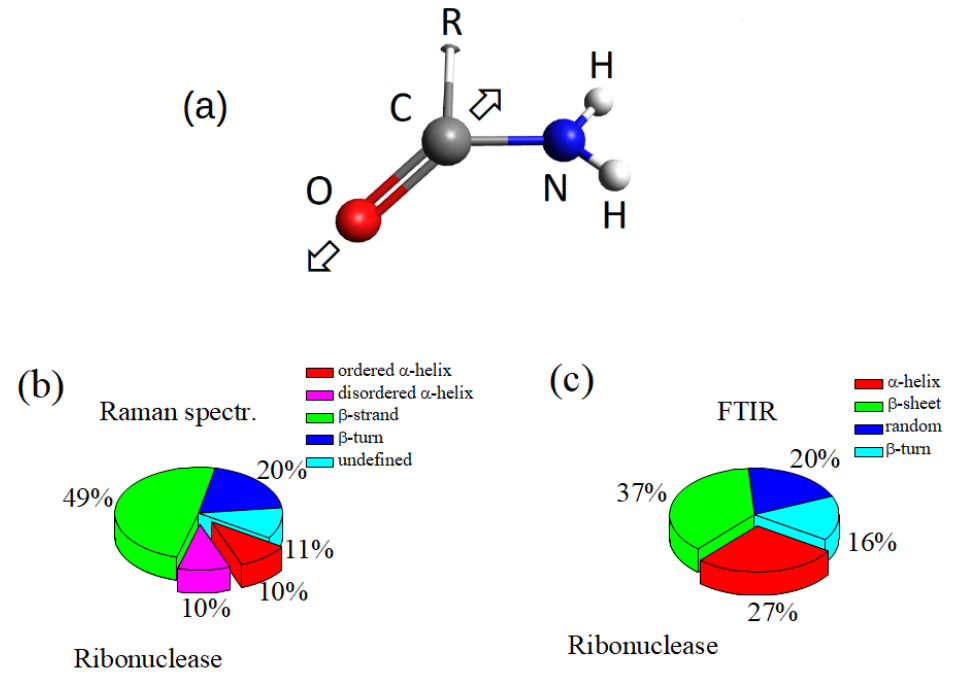
Figure 1. ( a ) Sketch of the Amide I functional group. “R” represents a not specified of organic group; the arrows indicate the bond vibration direction; ( b ) relative distribution of the secondary structures of the Raman response of Ribonuclease in the Amide I region [14]; ( c ) relative distribution of the secondary structures of the FTIR response of Ribonuclease in the Amide I region